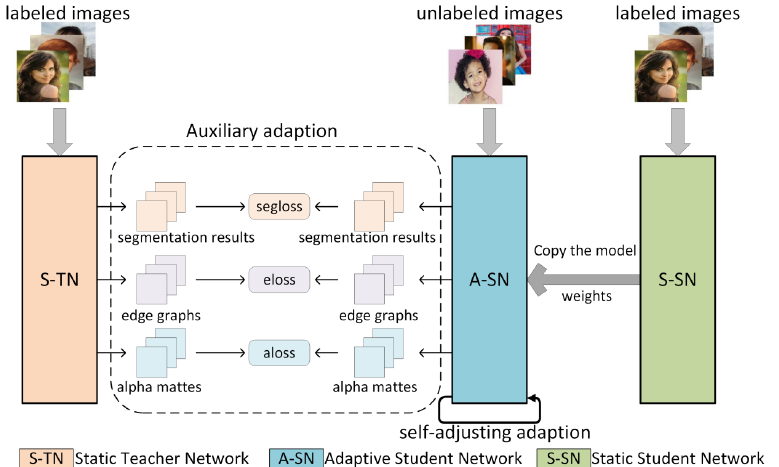
Figure 1. A schematic illustration of the collaborative process between our designed semi-supervisory network and two adaptive